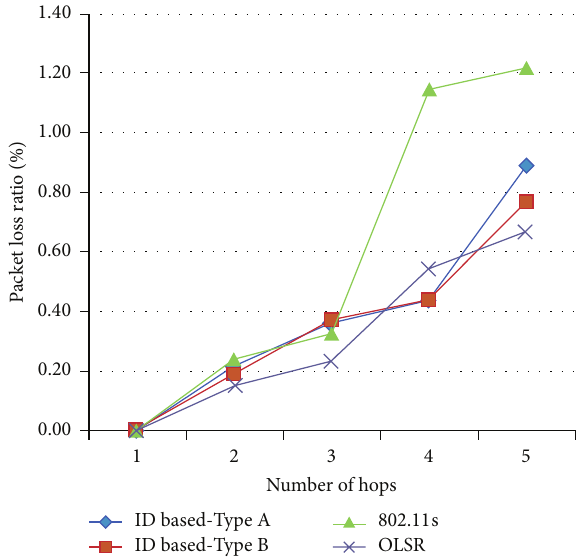
Figure 23: Packet loss ratio under different scenarios.